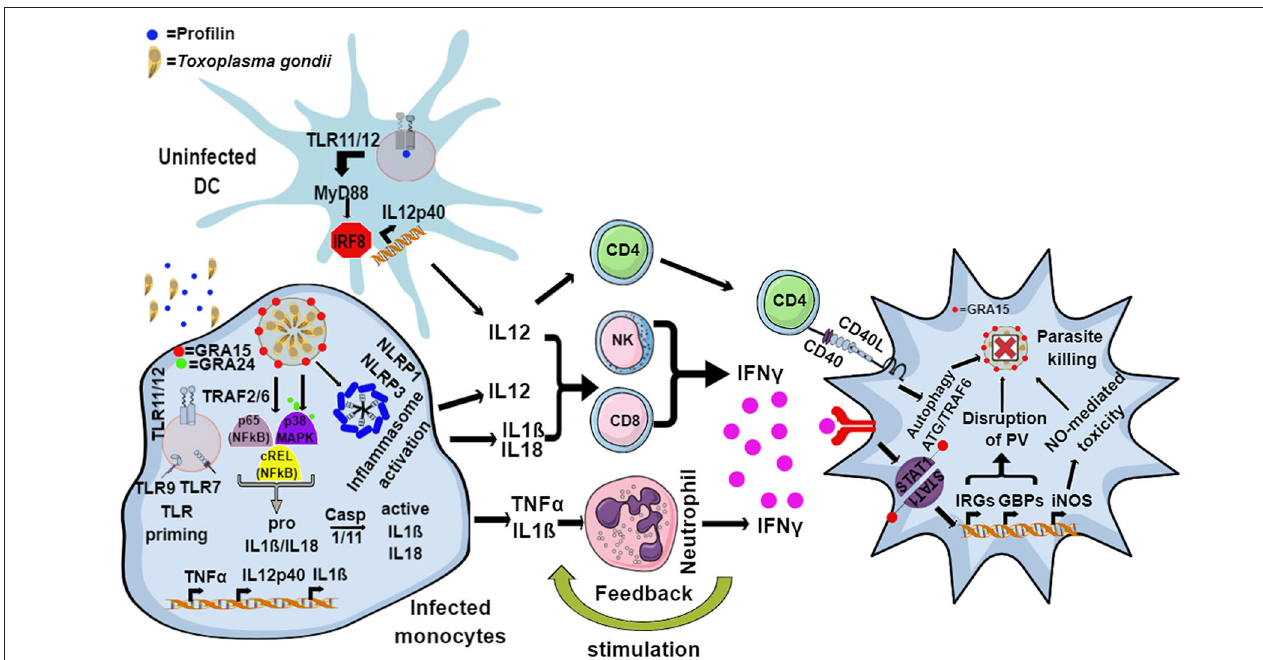
FIGURE 1 | Model for the murine immune response to Toxoplasma. The endosomal TLR11 and TLR12 heterodimeric complex in uninfected DCs recognizes Toxoplasma profilin, resulting in MyD88 and IRF8-mediated production of IL12. Infected monocytes and macrophages produce IL1 β and IL18 through the activation of the NLRP1 and NLRP3 inflammasome, while secretion of IL12 and TNF α is induced by GRA15- and GRA24-mediated activation of p65-NF κ B, cREL-NF κ B, and p38 MAPK pathways. Additionally, priming through nucleic acid sensing TLRs also leads to induction of IL1 β . IL12, along with IL18 and IL1 β , activates NK, CD4, and CD8T cells to produce host-protective IFN γ . IL1 β and TNF α act together to activate incoming neutrophils to secrete IFN γ , in turn inducing the expression of a battery of effector molecules including the immunity related GTPases (IRGs), guanylate binding proteins (GBPs), reactive oxygen species (ROS), nitric oxide (NO), and autophagy pathways inside the infected cells that eliminate the parasite.